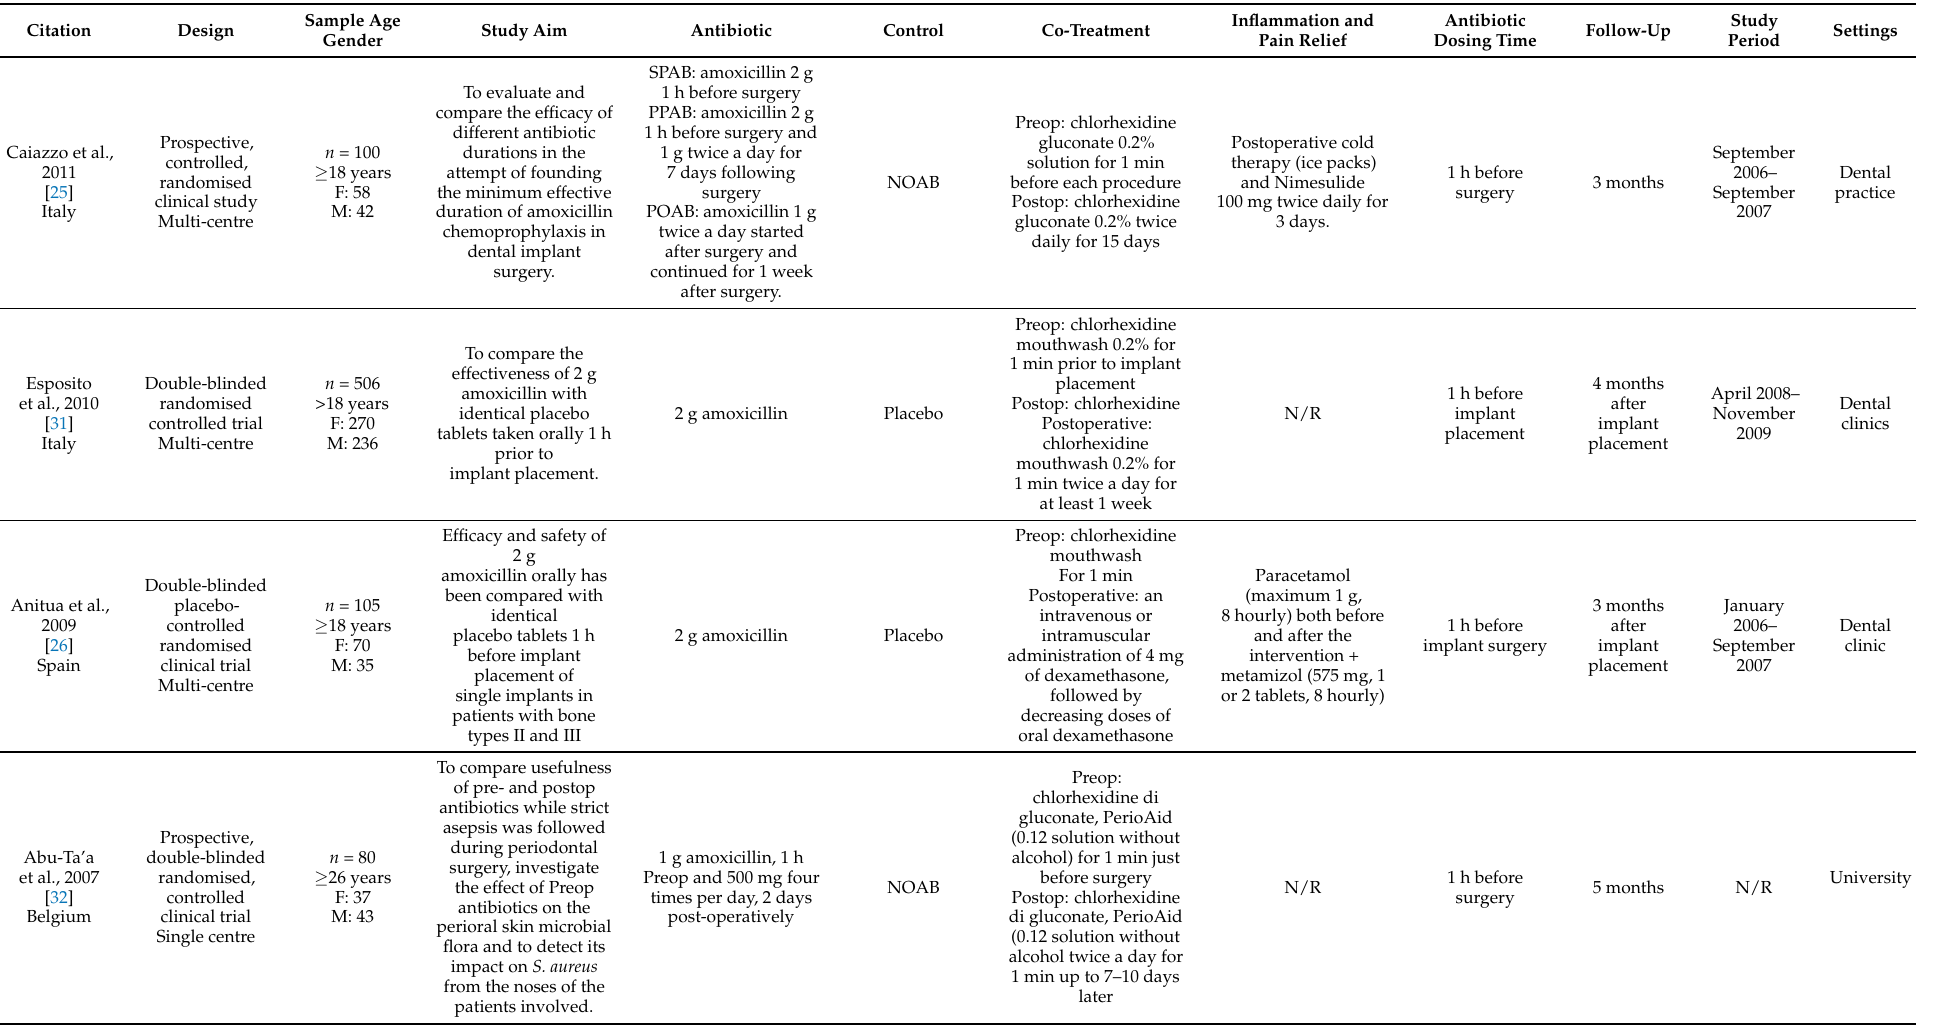
Table 1. Implant studies